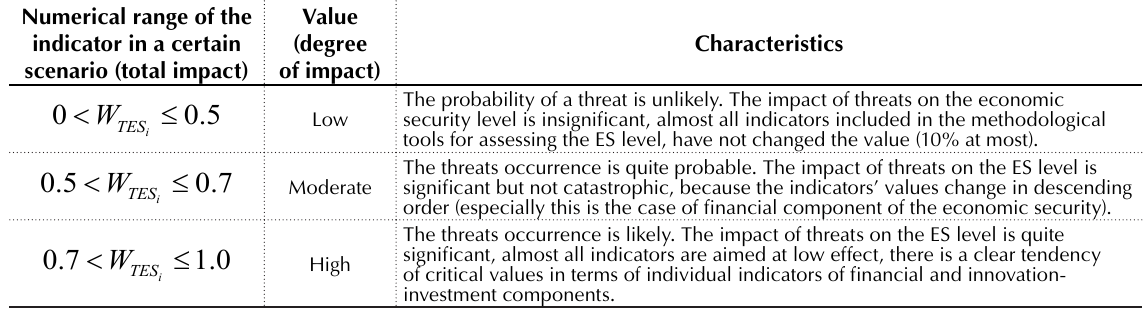
Source: Elaborated by the authors.